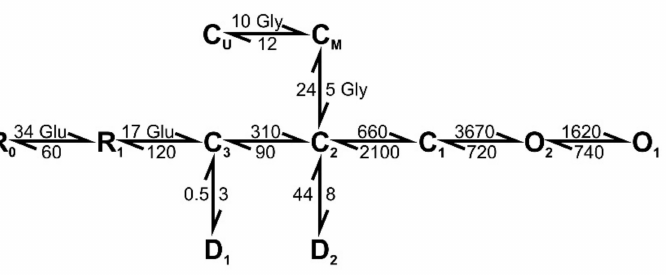
Figure 10. The kinetic scheme used for simulating the gating mechanisms of NMDARs. Rate constants above each arrow are given in s − 1 , except for the glycine-binding and glutamate-binding rate constants, which are in µ M − 1 s − 1 . Gly and Glu indicate the glycine and glutamate concentrations (in µ M),